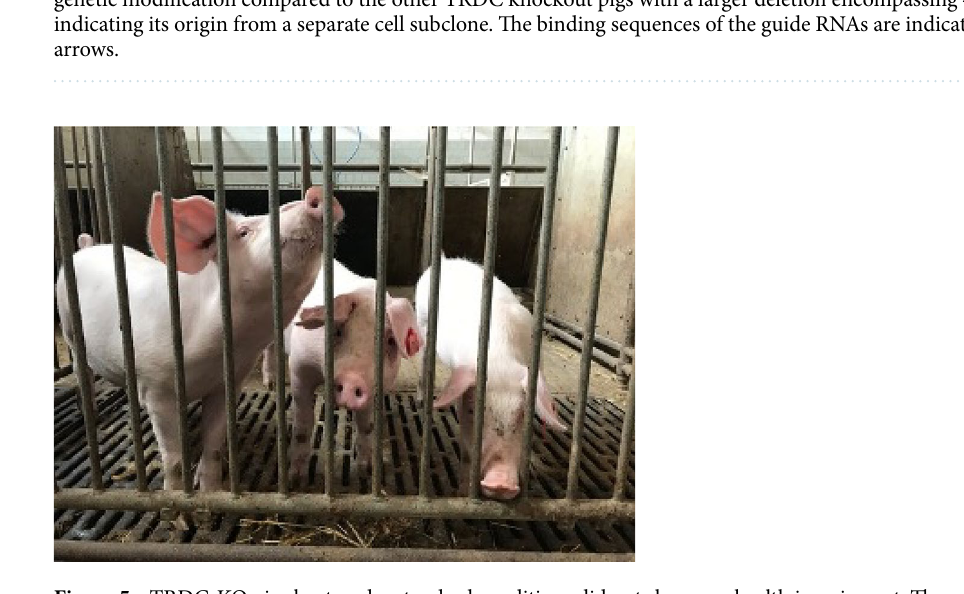
Figure 5. TRDC-KO pigs kept under standard conditions did not show any health impairment. Three TRDC- knockout pigs from intracytoplasmic